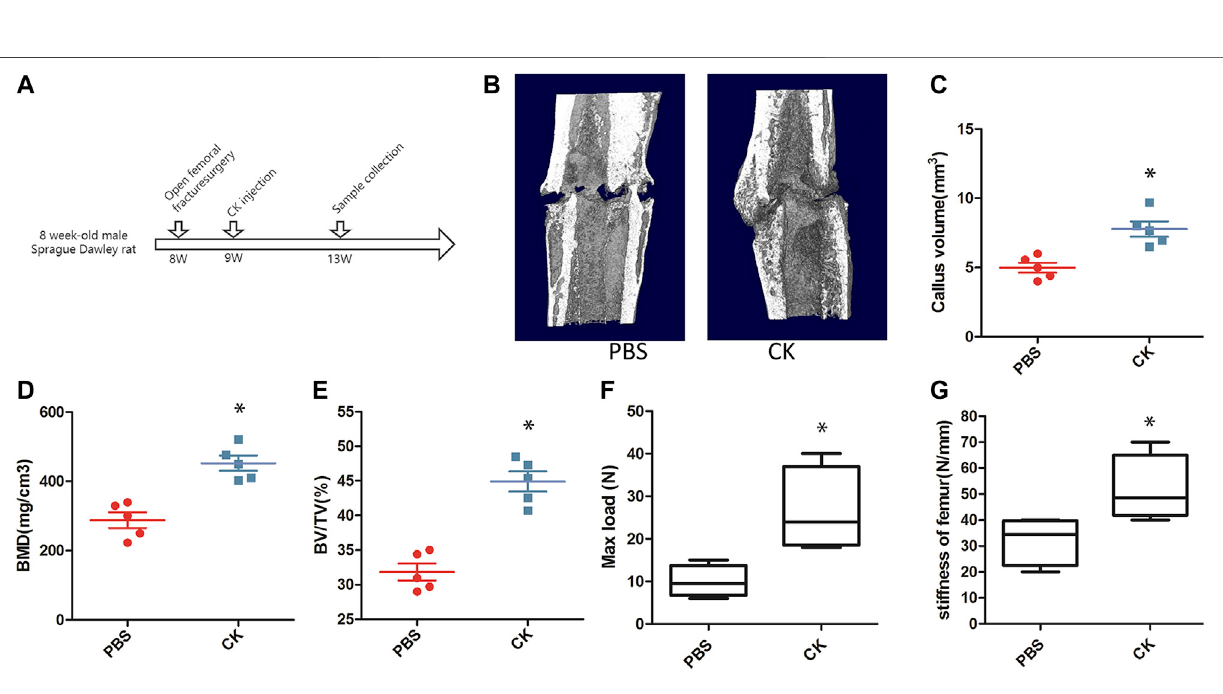
Frontiers in Pharmacology |